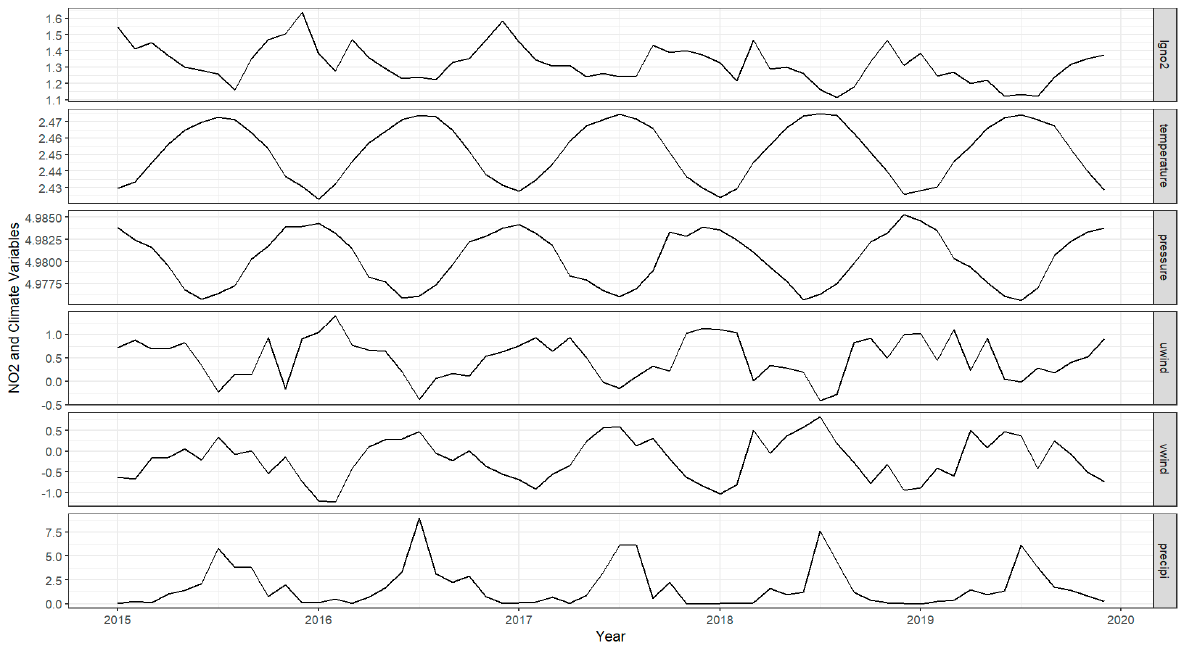
Figure 3. Initial analysis graph based on characteristics of monthly average of NO 2 emissions from 2015 to 2019 and meteorological factors (temperature, precipitation, wind, surface pressure) in Beijing China. lgno2 represents the logarithm of NO 2 , uwind represents Eastward component of the 10 m wind, vwind represents Northward component of the 10 m wind, and precipi represents precip- itation.